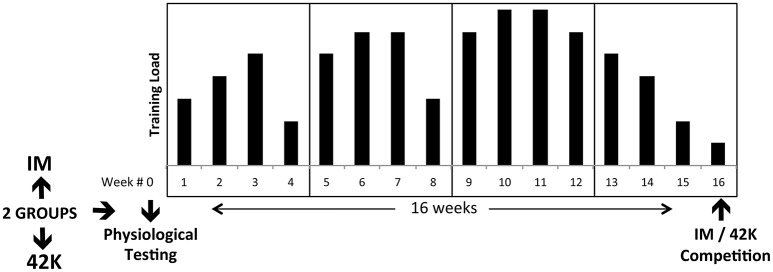
Experimental design. Planned training load is described with arbitrary units, with the purpose of showing general trend of hard/easy weeks.